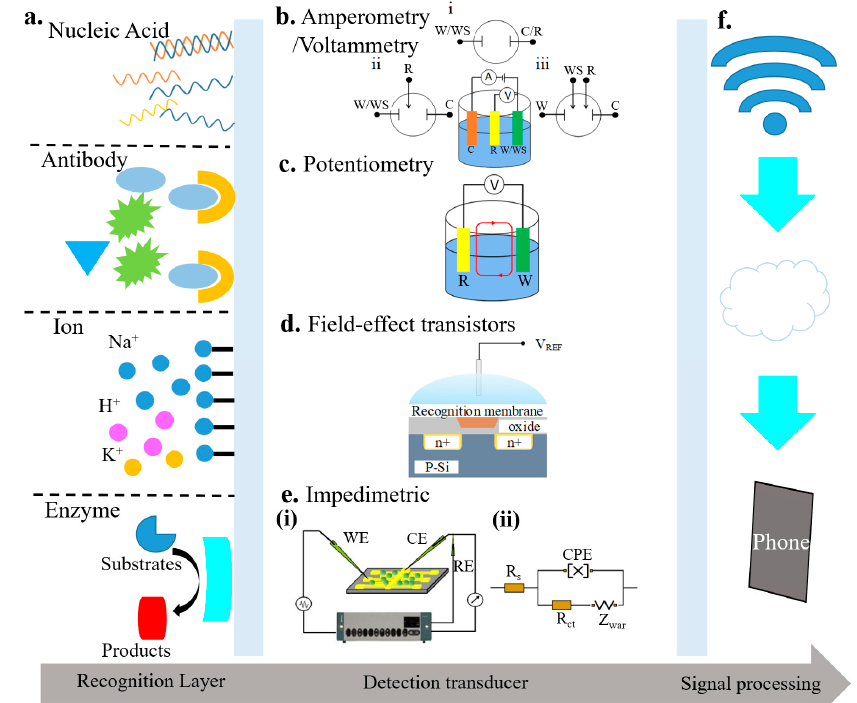
Figure 2. Schematic of electrochemical biosensors that include ( a ) a recognition element (e.g., nucleic acid, antibody, ions, or enzyme) and a detection transducer, along with a corresponding signal processing unit; reproduced with permission from [63]; Copyright 2016, The Royal Society of Chemistry. The detection transducer could be ( b ) amperometric / voltammetric sensors with (i) two-, (ii) three-, or (iii) four-electrode configuration (reproduced with permission from [63]; Copyright 2016, The Royal Society of Chemistry), ( c ) a potentiometric sensor (reproduced with permission from